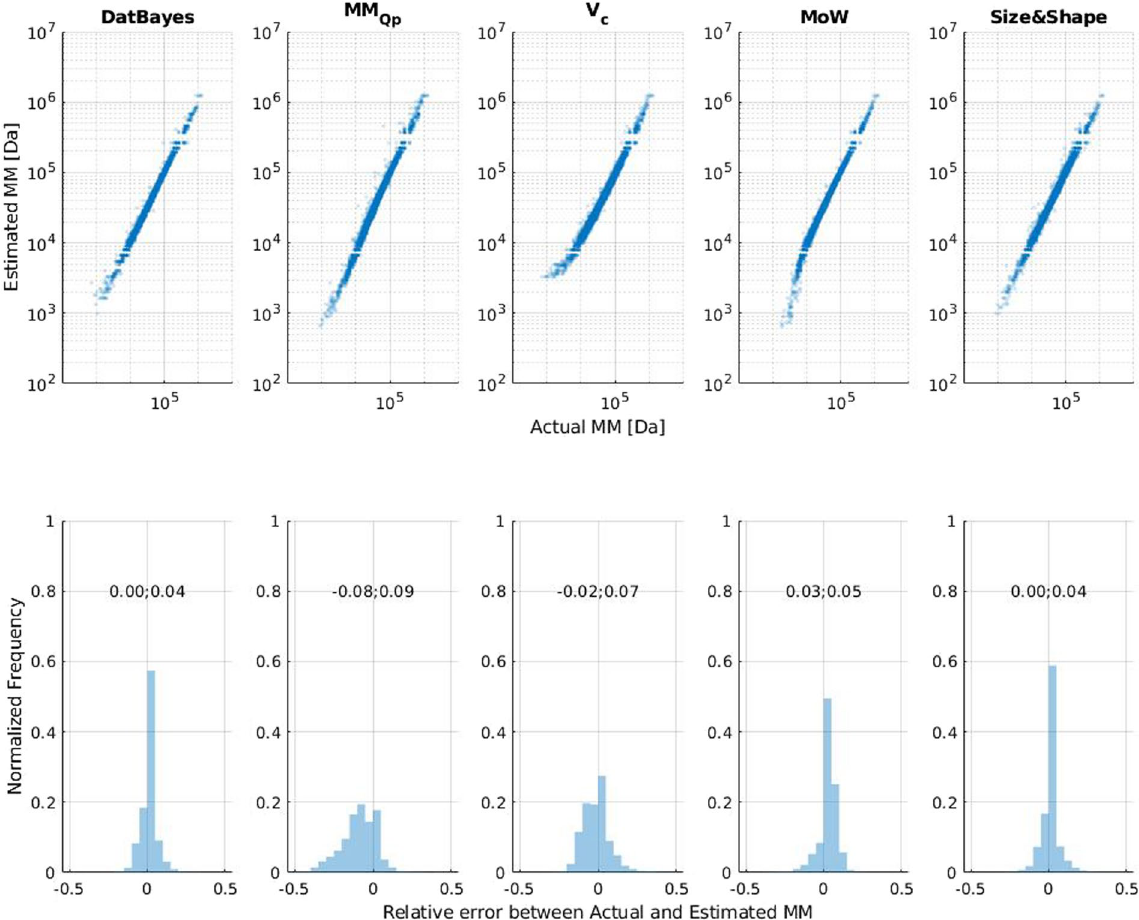
Figure 4. Qualitative overview of accuracy for ideal data. Dataset for ideal data with no simulated noise, dataset size is 16,563. The MM’s are expressed in terms of value of the bin (Fig. 3) which the MM falls into. Top: Scatter plot of the estimated MM vs Actual MM. Bottom: Same data as top-panel but plotted as distributions of the relative error between the actual and estimated MM. Finally the median and the median absolute deviation (mad) is shown above each